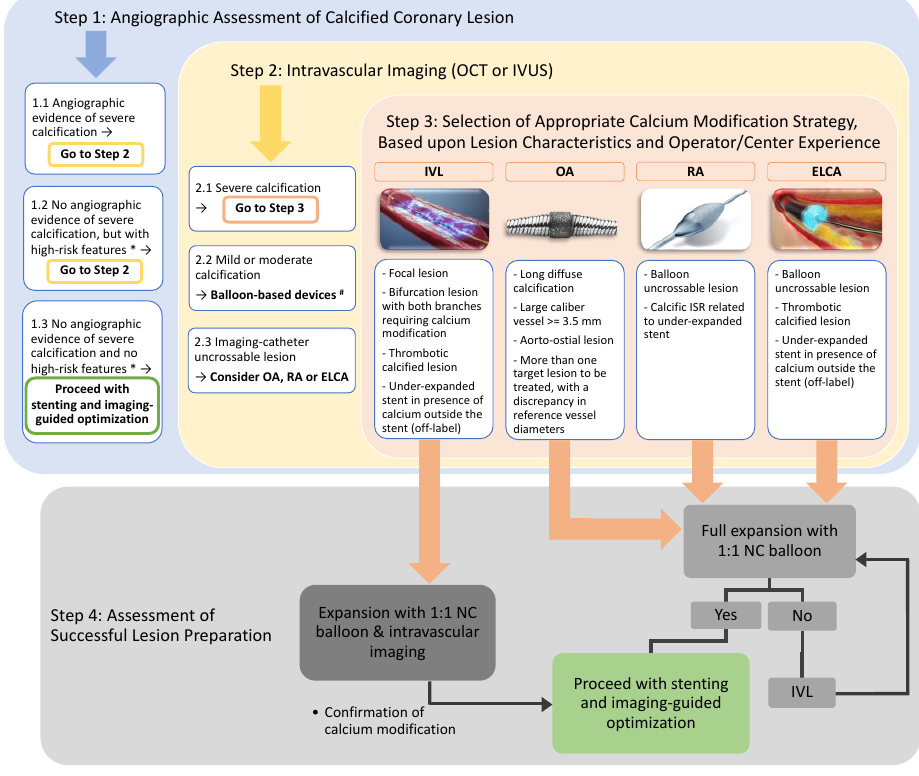
Figure 1. Algorithmic approach for management of calcified coronary lesions.